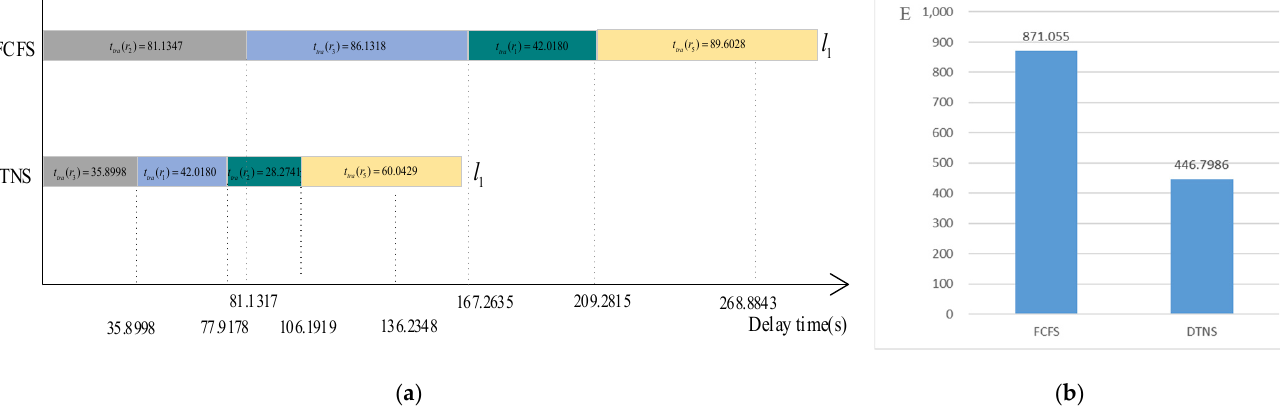
Figure 11. Comparison of efficiency under the condition of one robot-trailer in scenario 2. ( a ) Comparison of towing service time. ( b ) Comparison of delay expectations.